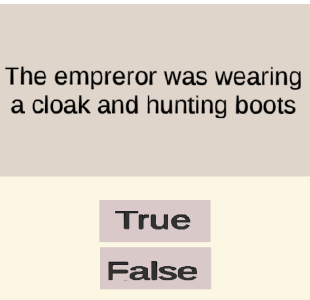
Figure 9: Example of a question about the sculpture